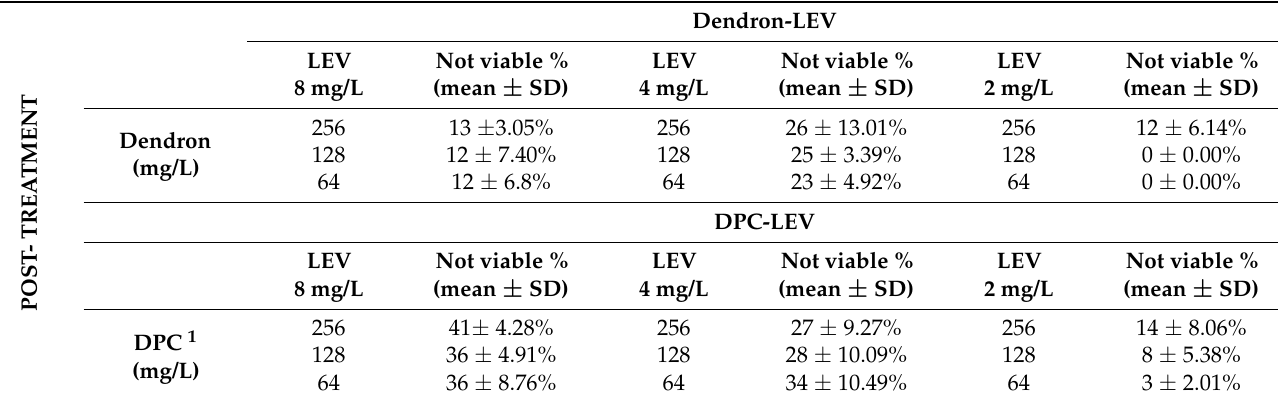
Table 3. Percentage of non-viable biofilm cells for the different combinations of Dendron-LEV vs. DPC-LEV in the post-treatment of S. aureus biofilm (inhibition of established